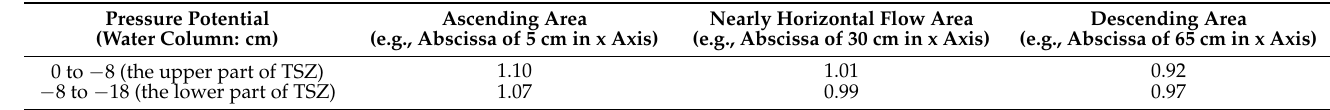
Table 2. Comparison of pressure potentials for each area (cm). Vertical Distance above Ascending Area Water Table (e.g., Abscissa of 5 cm in x